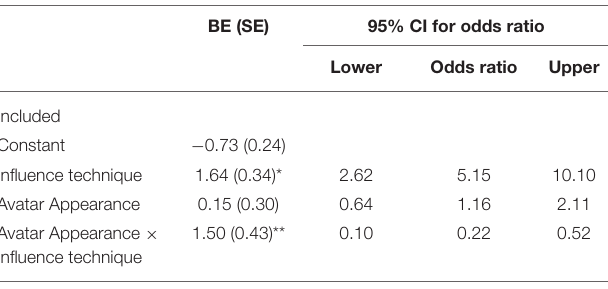
TABLE 2 | Binary logistic